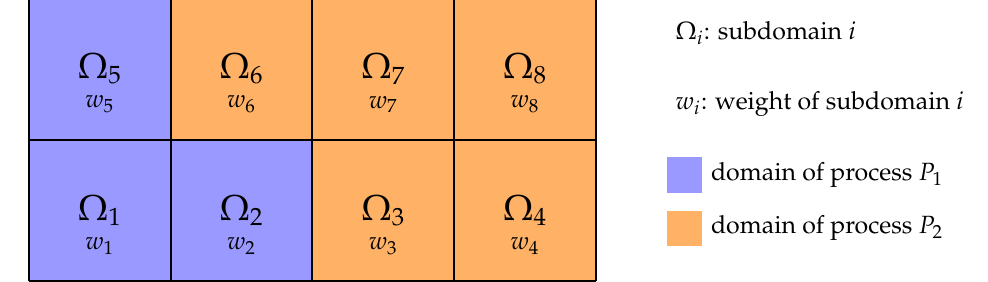
Figure 1. Illustration of domain partitioning with load balancing. The computational domain Ω is subdivided into subdomains Ω i , such that Ω = (cid:83) i Ω i . The load estimator assigns a weight w i to each subdomain that quantifies the workload. The load distribution routine then assigns the subdomains to the available processes (here P 1 and P 2 ) such that the load per process is